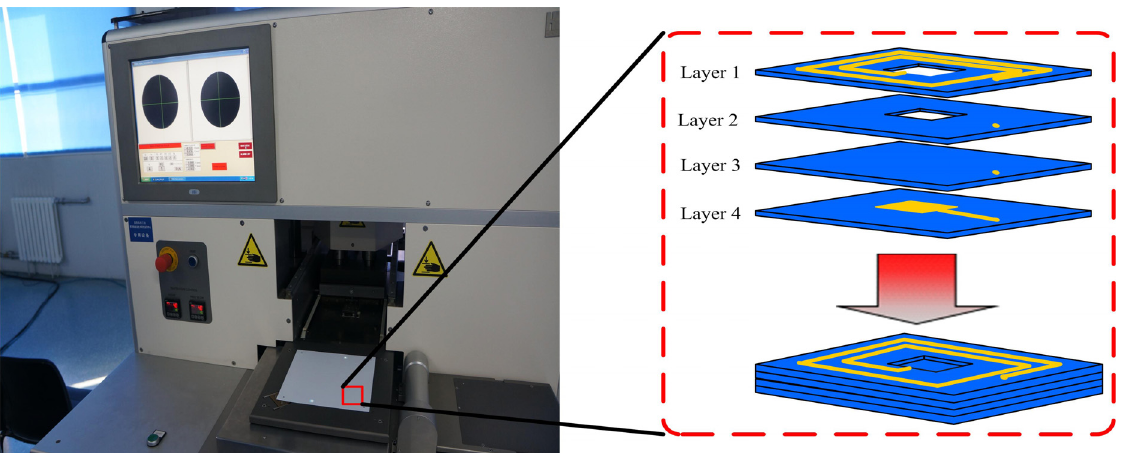
Figure 5. Laminating